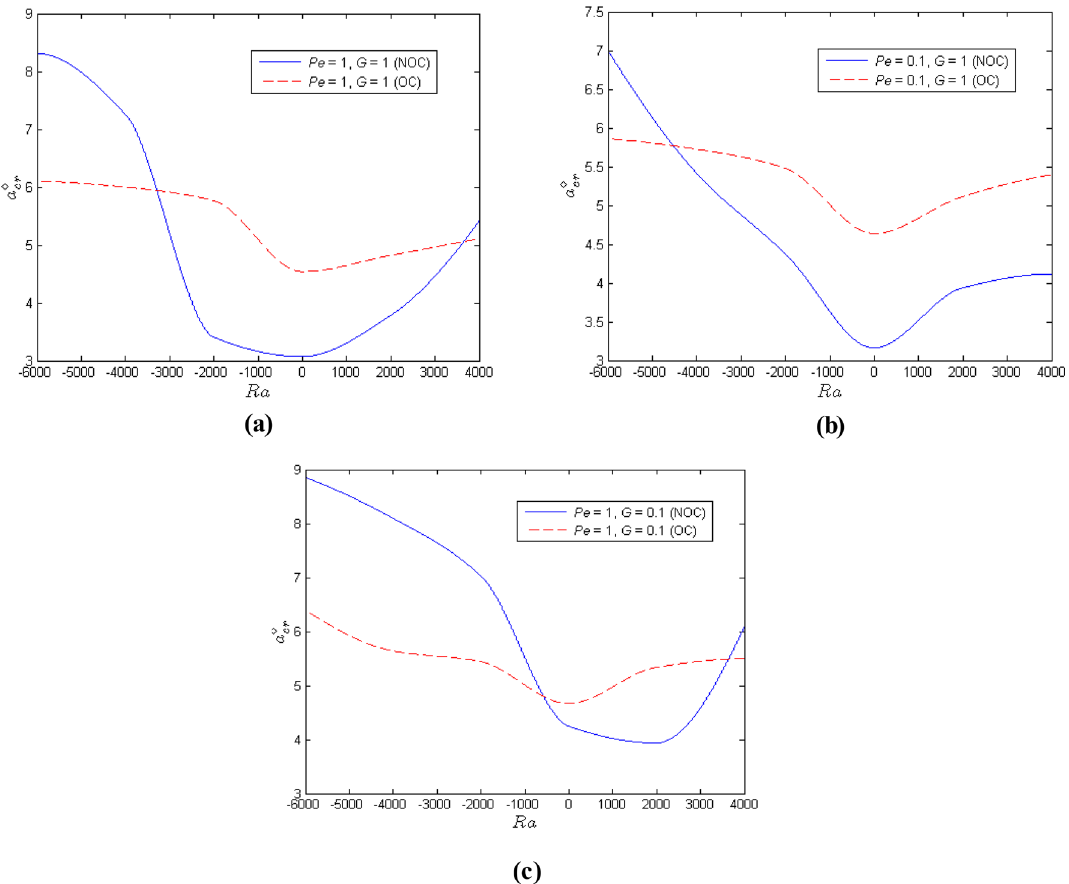
Fig. 3 The case of rigid upper and rigid lower walls: a – c Variation of thermal Rayleigh number verses critical wave number for the non–oscil- latory and oscillatory modes of instability for the different values of Péclet number Pe and Gyrotactic number